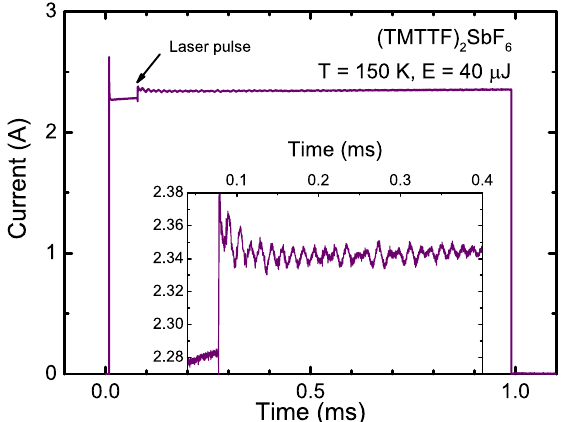
Figure 8. Current response to a 1 ms long 5 V voltage pulse applied on a (TMTTF) 2 SbF 6 crystal at a temperature of 150 K. At about t = 0.075 ms, an additional laser pulse of E = 40 µ s (black arrow) illuminates the sample. This induces a photocurrent, visible in the steep, weak jump of the current signal. In the inset the first 400 µ s of the photocurrent response are magnified. Interestingly, overall signal is are superimposed with pronounced